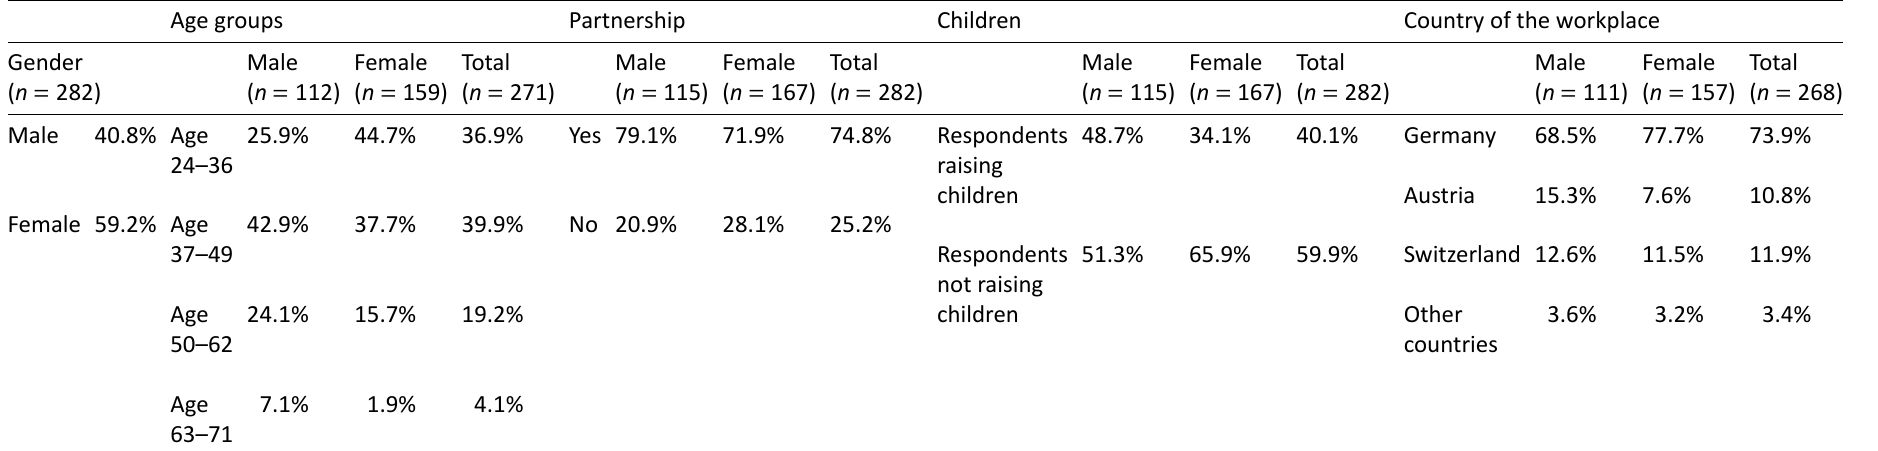
Table 1. Sample: A socio‐demographic